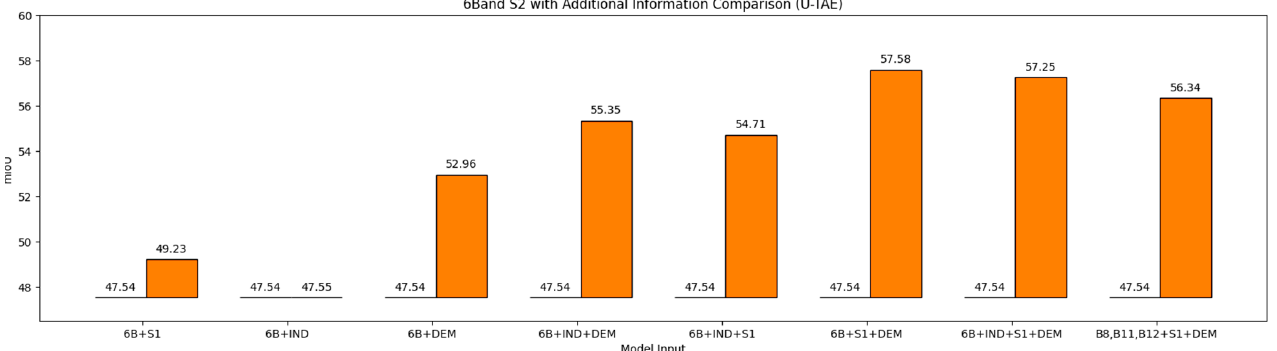
Figure 10. mIoU scores for U-TAE models using di ff erent band combinations. At the left of each bar, the mIoU score resulting from the U-TAE model for the 6B band con fi guration is presented as a baseline.